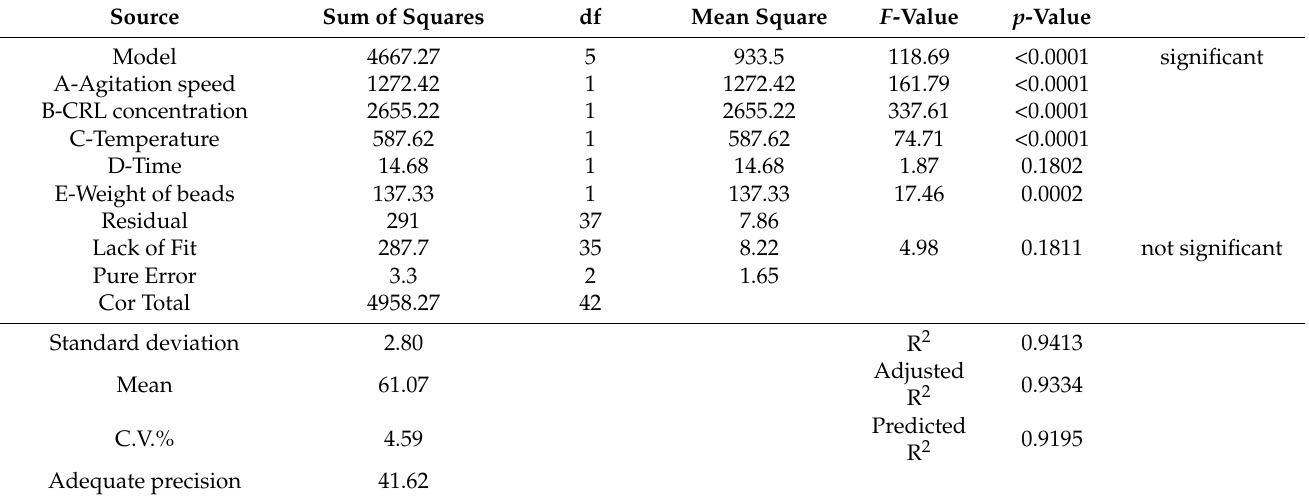
Table 2. Analysis of variance (ANOVA) and fit statistics of the linear model for activity recovery